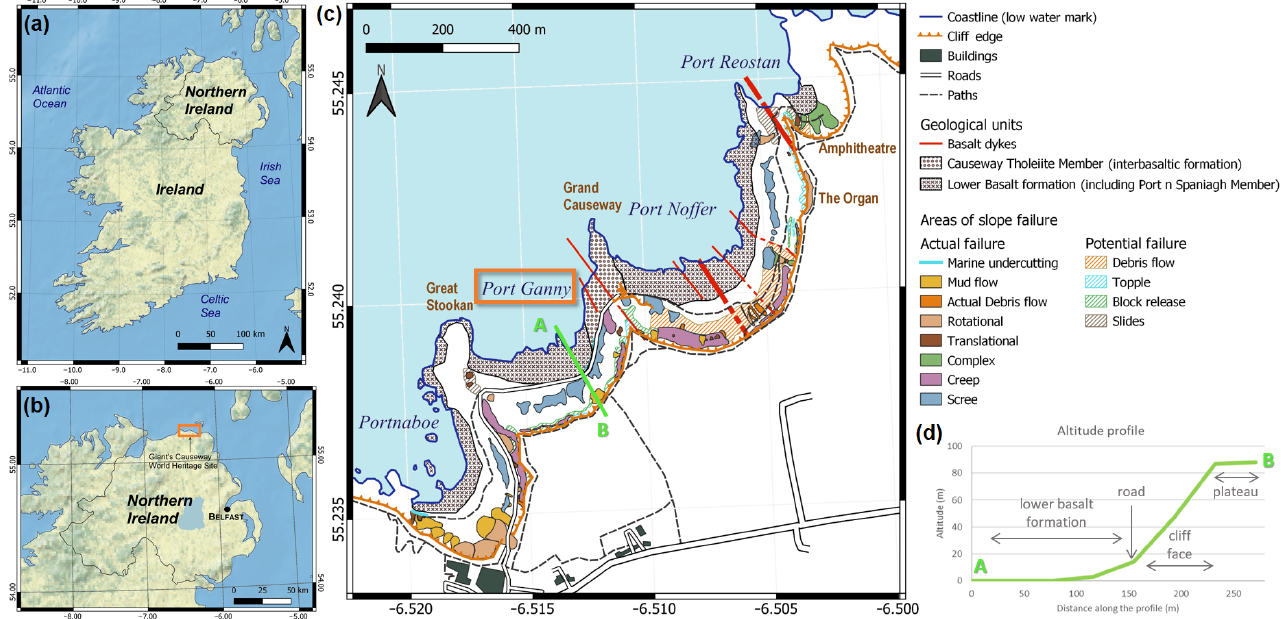
Figure 1. ( a , b ) Location of the Causeway Coast and Giant’s Causeway in Northern Ireland. ( c ) Map of the Causeway Coast, with geological and geomorphological information, and an identification of actual or potential failure areas (mainly based on Reference [21]). ( d ) Altitude along the AB profile in Port Ganny. This study focuses on surveys carried out in Port Ganny, immediately west of the Grand Causeway ( c ).